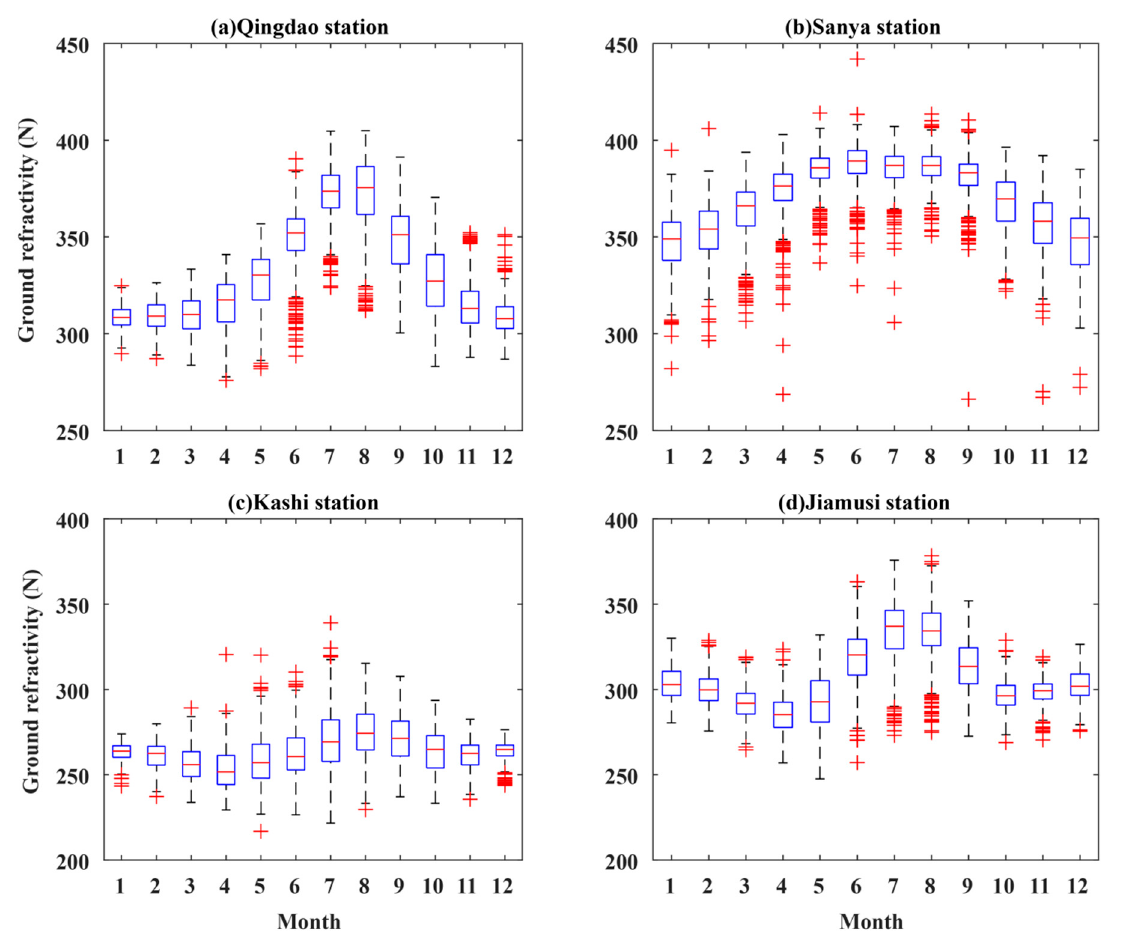
Figure 11. Boxplot of the ground refractivity in different months of 10 years’ radiosonde data, the red marks represent outlier data of refractivity.